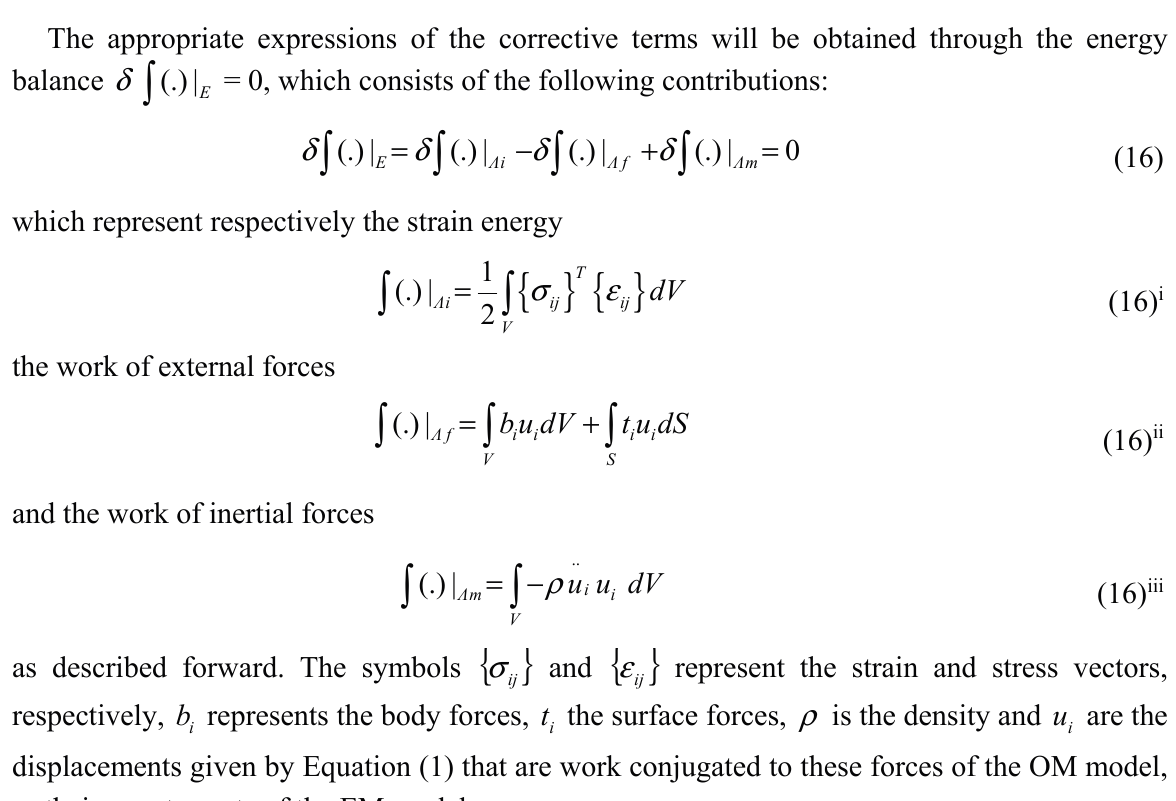
Figure 2. Stages of the procedure employed to obtain the equivalent C 0